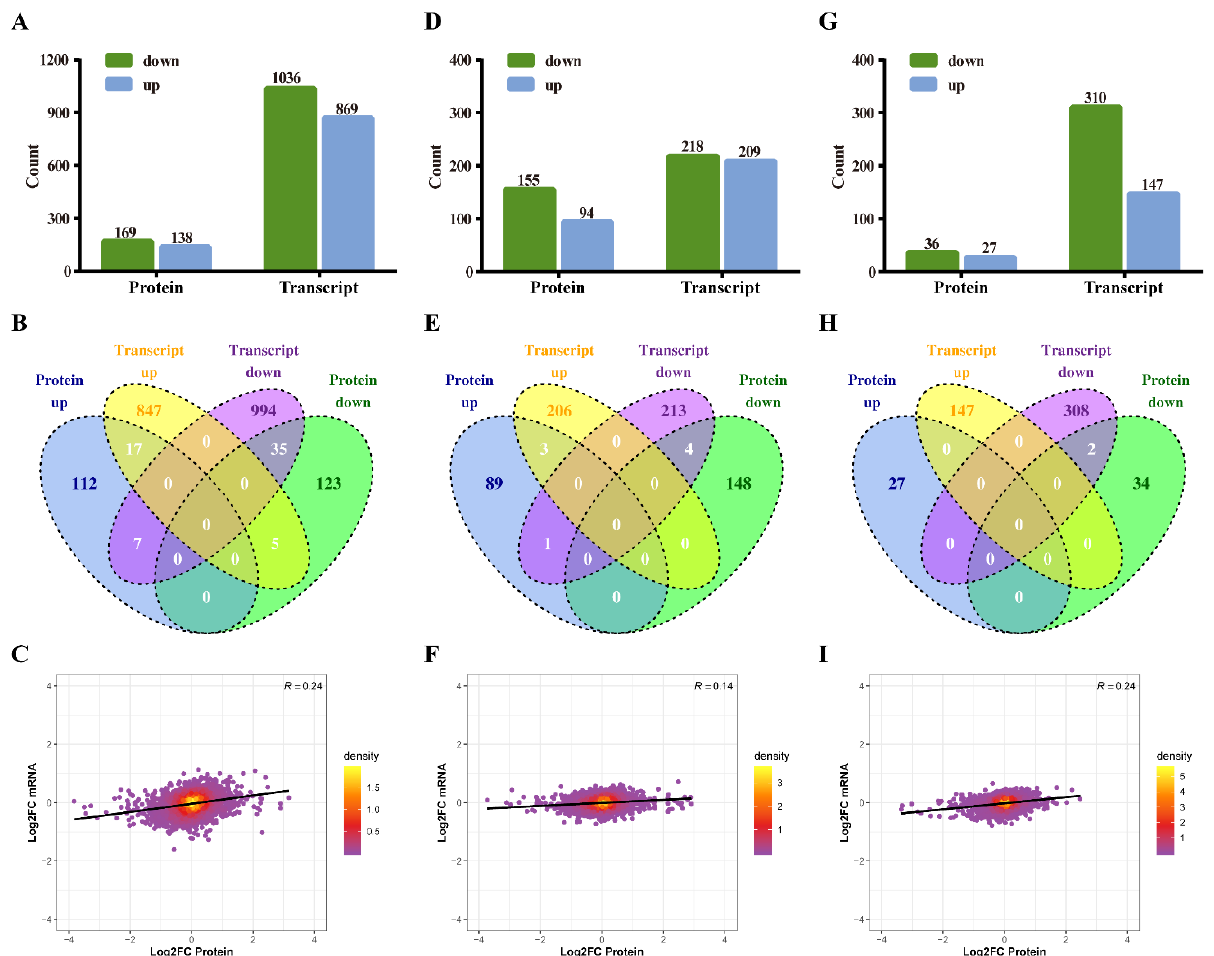
Figure 7. Correlation analysis of proteomics and transcriptomics. Rabbits ( n = 9/group) were chal- lenged 4 weeks after boosting by ear vein injection with live Bb (2.4 × 10 10 CFU/rabbit). Spleens ( n = 3/group) were harvested 7 days after infection and used for proteomic and transcriptomic analyses. ( A , D , G ) The numbers of differentially expressed proteins (DEPs) and genes (DEGs) quantified in the protein and transcript libraries. ( B , E , H ) Venn diagrams of up- and downregulated DEPs and DEGs. ( C , F , I ) Scatterplot of the relationship between genes identified in the protein and